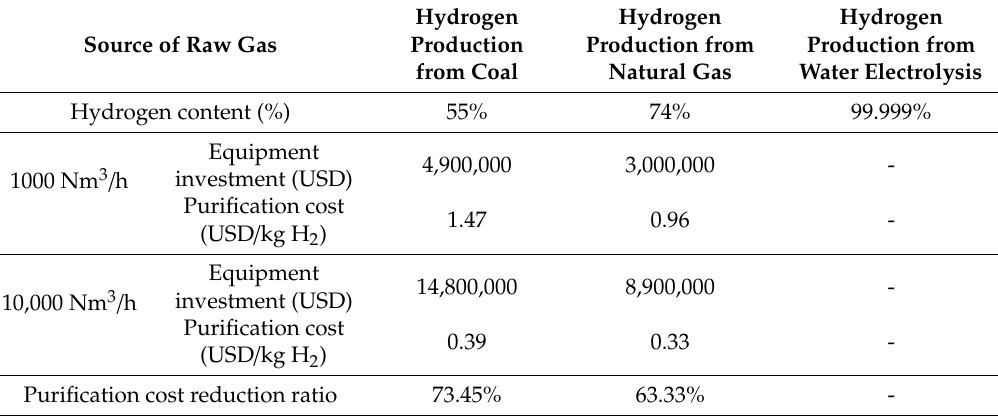
Table 7. Purification cost analysis of two raw gas sources.